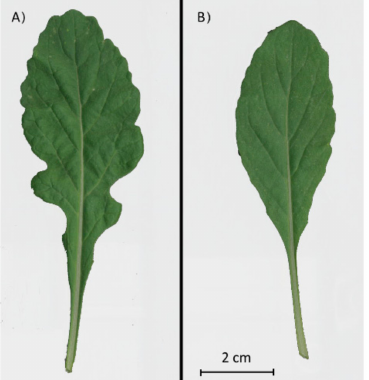
Figure 2. Di ff erences in leaf traits between the upper ( A ) and lower ( B ) leaves.